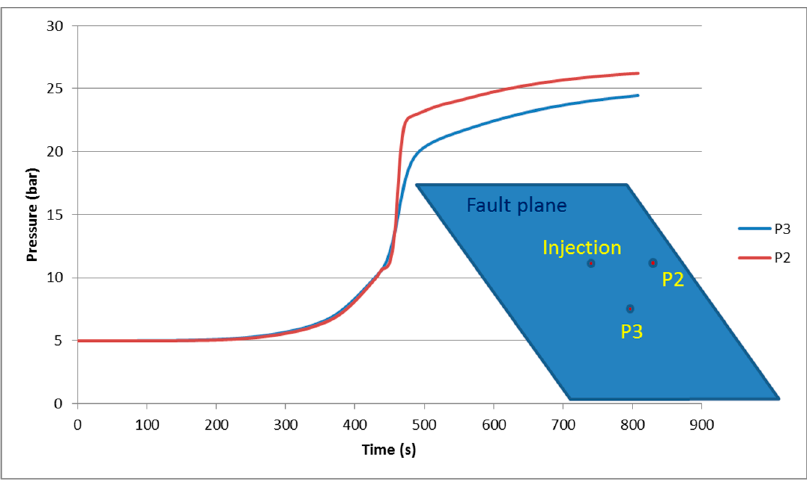
Figure 14. Effect of heterogeneity on pressure response ( β = 1.8).